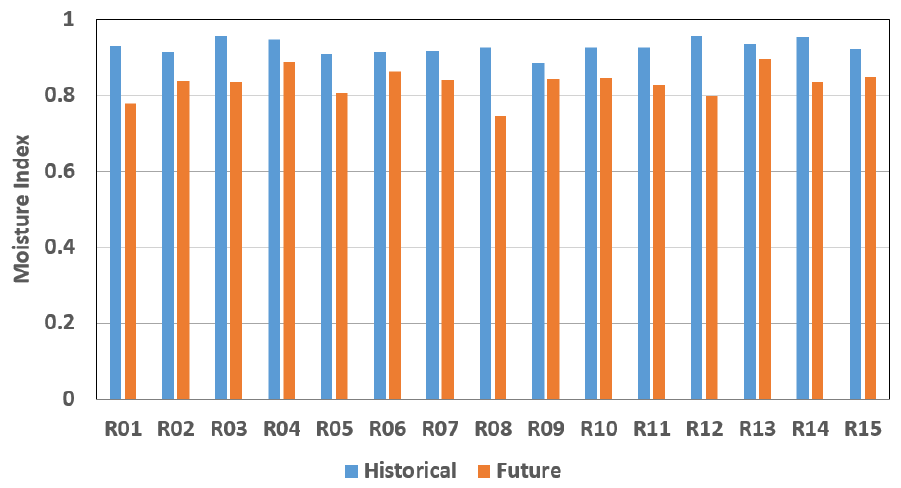
Figure 2. 2-year’s averaged MIs of 15 climatic realisations.